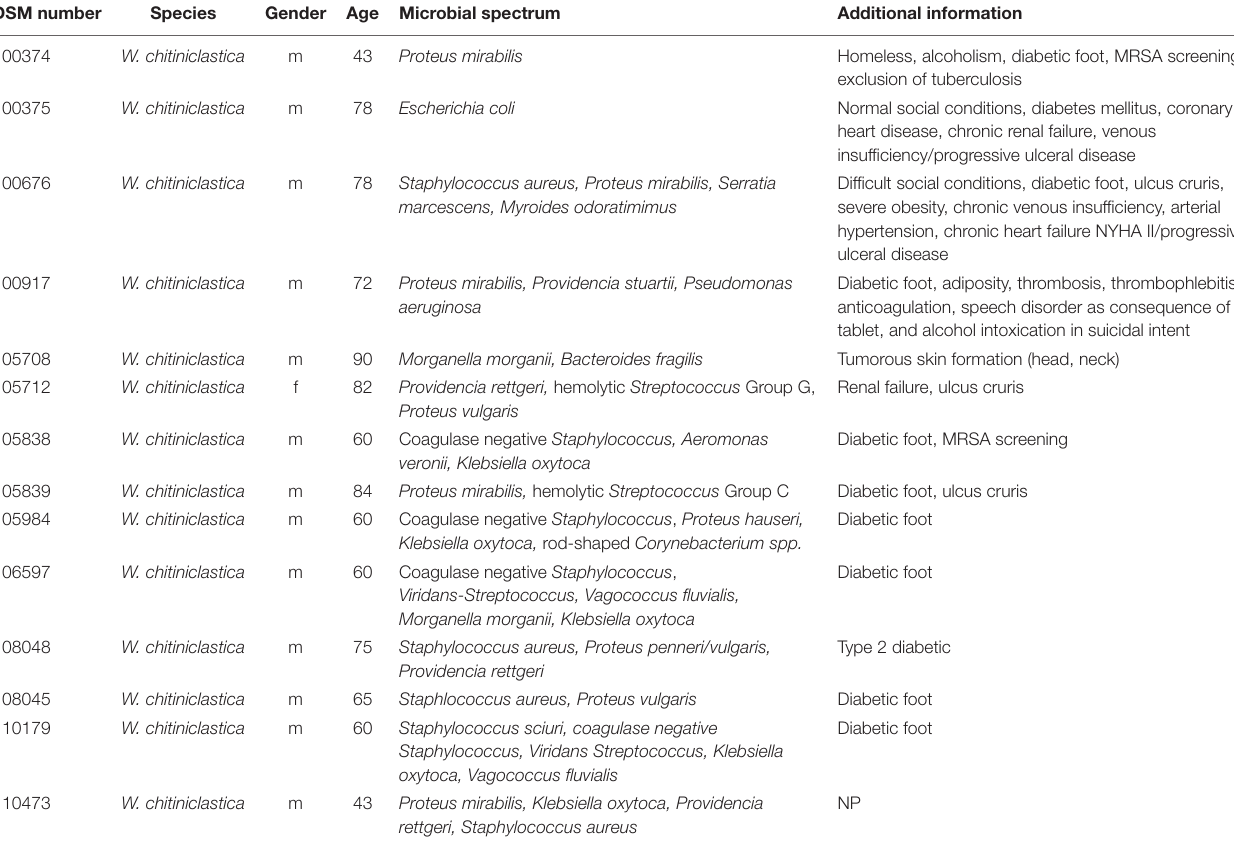
TABLE 2 | Strain sources and patients’ clinical